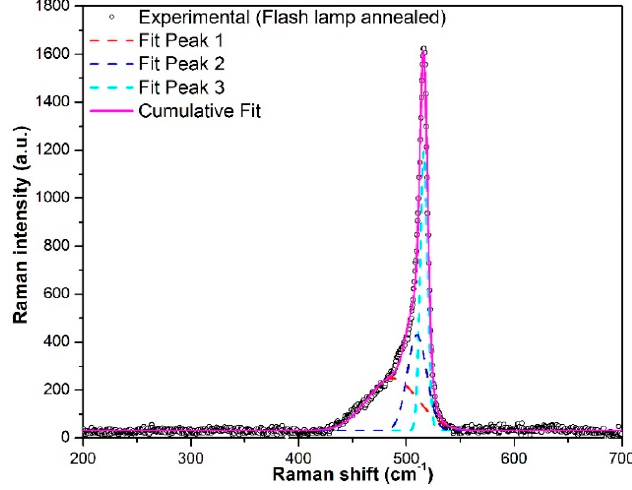
Figure 11. Raman spectra of flash lamp annealed PECVD silicon thin film. The expermental data is shown with symbol (o), solid magenta color represents cumulative Gaussian fit, and the remaining three dotted curves are deconvoluted Gaussian peaks.